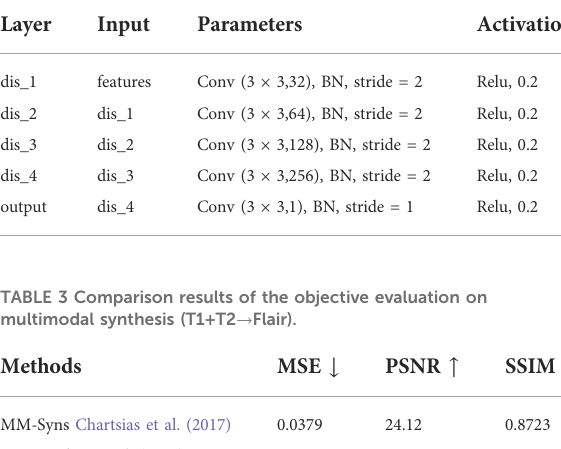
TABLE 1 Architecture of the pixel-level discriminator. TABLE 2 Architecture of the feature-level discriminator.